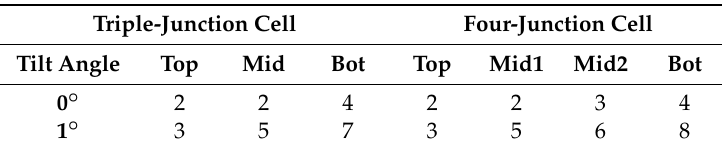
Table 6. PAR (peak-to-average of J conc ) values of both MJSC for each subcell under normal incidence of Table 6 . PAR (peak-to-average of J sc,iconc ) values of both MJSC for each subcell under normal incidence sc , i the light and under 1 ◦ of tilt of the light and under 1° of tilt angle.